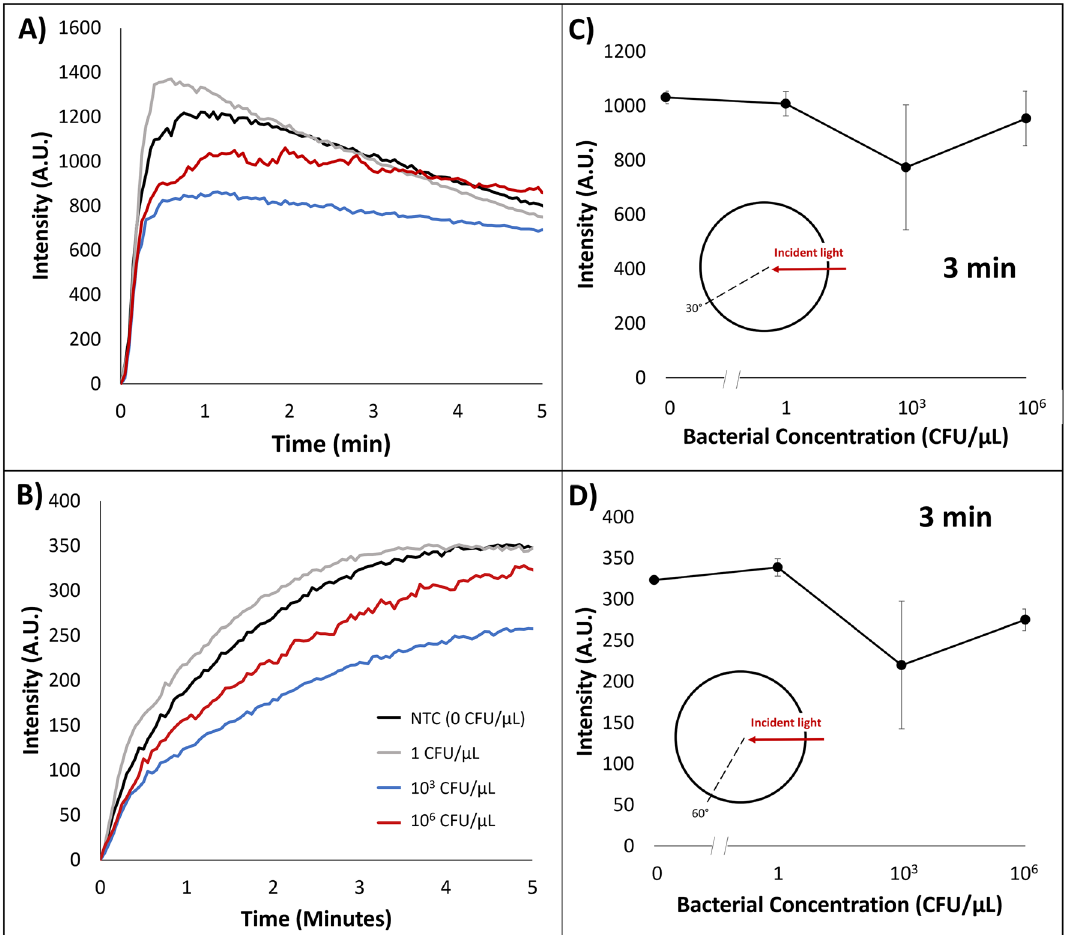
Figure 4. Emulsion LAMP light scatter intensity with relation to time collected at ( A ) 30° and ( B ) 60° angles with respect to a 650 nm wavelength incident light with bacteria solution droplets (along with BSA as stabilizer), varying concentrations of 10 6 ,10 3 , 1, and 0 CFU/µL. ( A and B ) are the representatives chosen from 3 replicates for each concentration. Light scatter intensity at 3 min collected from ( C ) 30° and ( D ) 60° angles at various bacterial